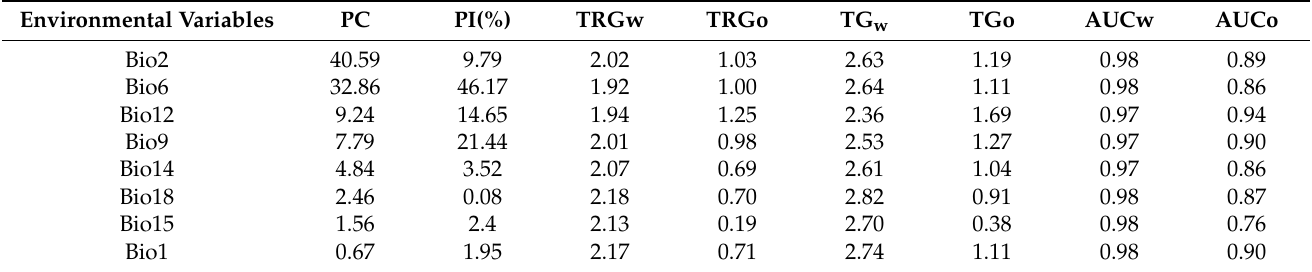
Table 1. Environmental variables and their main parameters of Glyptostrobus pensilis